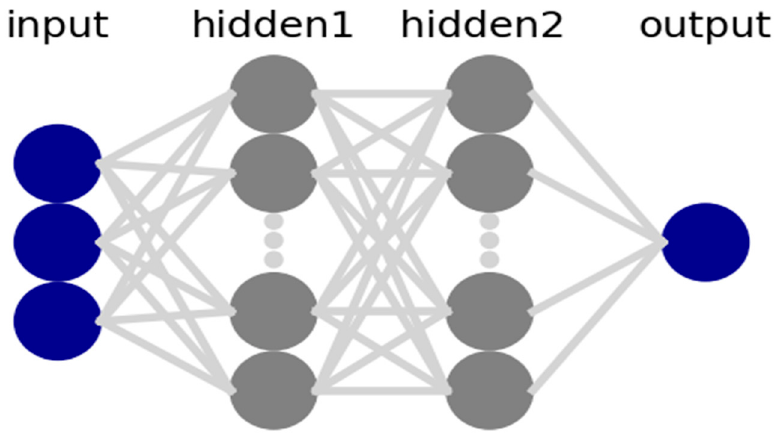
Figure 3. ANN model structure.